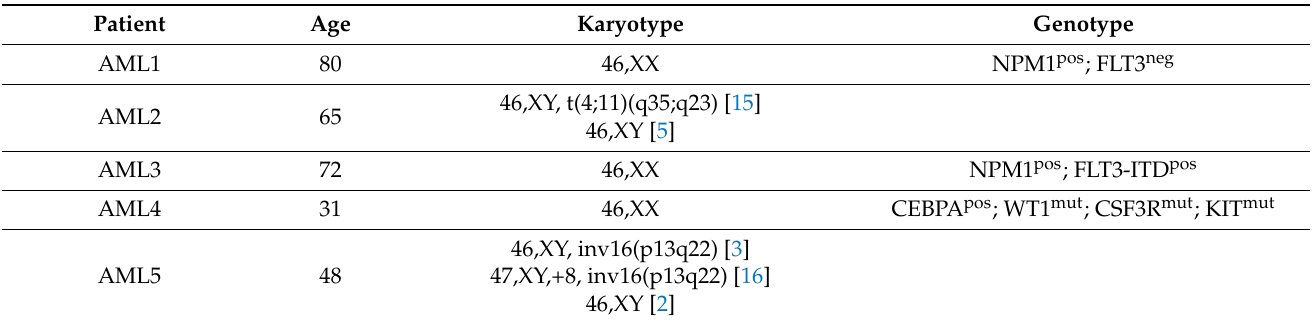
Table 4. Primary AML cells used in the present